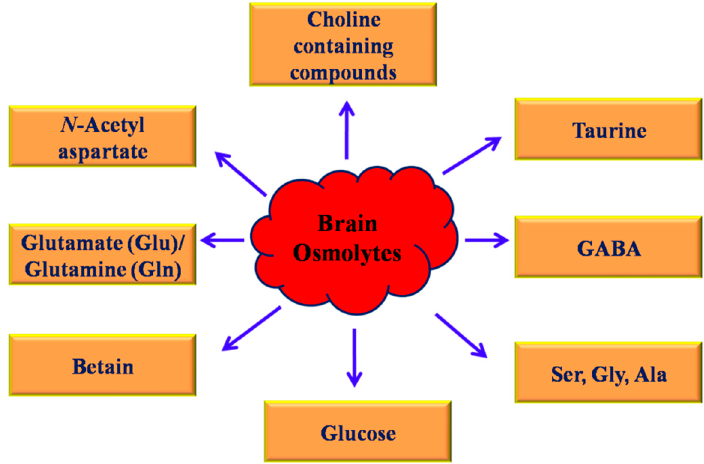
Figure 3. Major classes of the brain osmolytes.